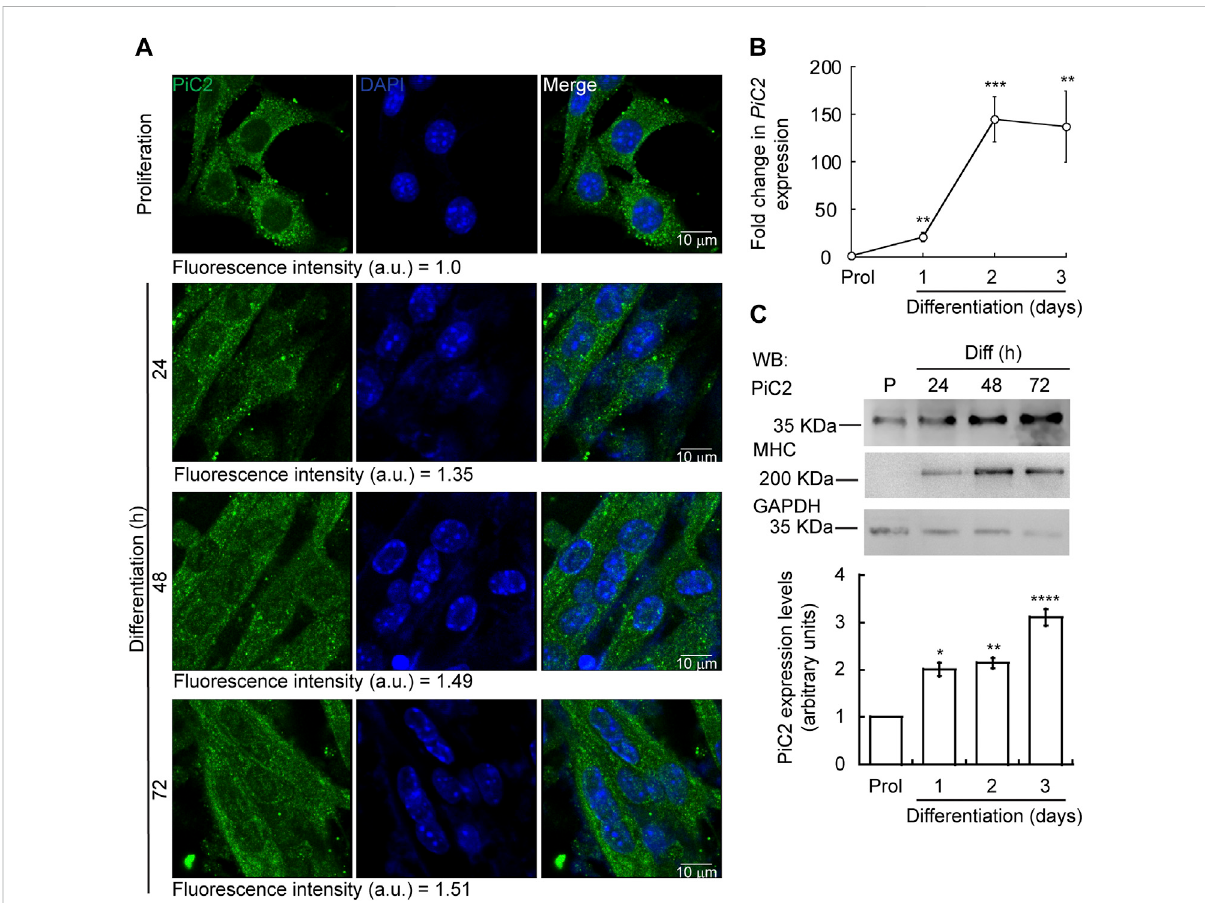
FIGURE 1 Expression of mPiC2 increases over the course of differentiation in primary myoblasts derived from mouse satellite cells. (A) Representative confocal microscopy analysis of PiC2 expression and localization. Proliferating (48 h) and differentiating (24 h, 48 h, and 72 h) primary myoblasts were fi xed, and stained with a fl uorescent antibody against PiC2 (green) and DAPI (blue). (B) mPiC2 mRNA expression is induced during differentiation. qRT-PCR analysis of mPiC2 mRNA levels. Values normalized to Ef1 α and non-differentiated (Prol) controls, n = 3. (C) mPiC2 proteinexpression isinducedduringdifferentiation. Representative western blotofPiC2proteinlevels(toppanel)and quanti fi cation(bottom panel). Membranes were blotted with PiC2, the differentiation marker myosin heavy chain (MHC), and GAPDH was used as loading control. n = 3 All values are reported as means ± SEM. Signi fi cance was determined by two-way ANOVA; * p < 0.05, ** p < 0.01, *** p < 0.001 and **** p < 0.0001 compared to Prol